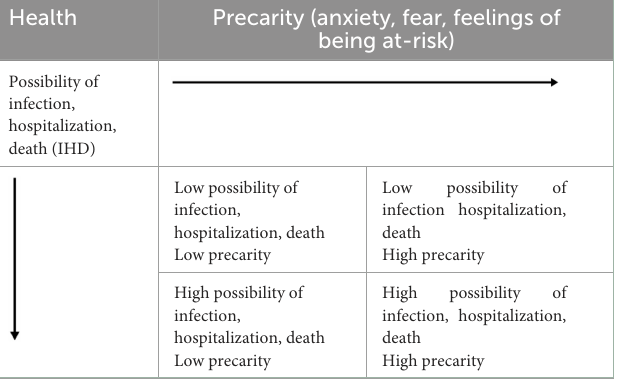
TABLE 8 Final typology, with sources of distress mapped against